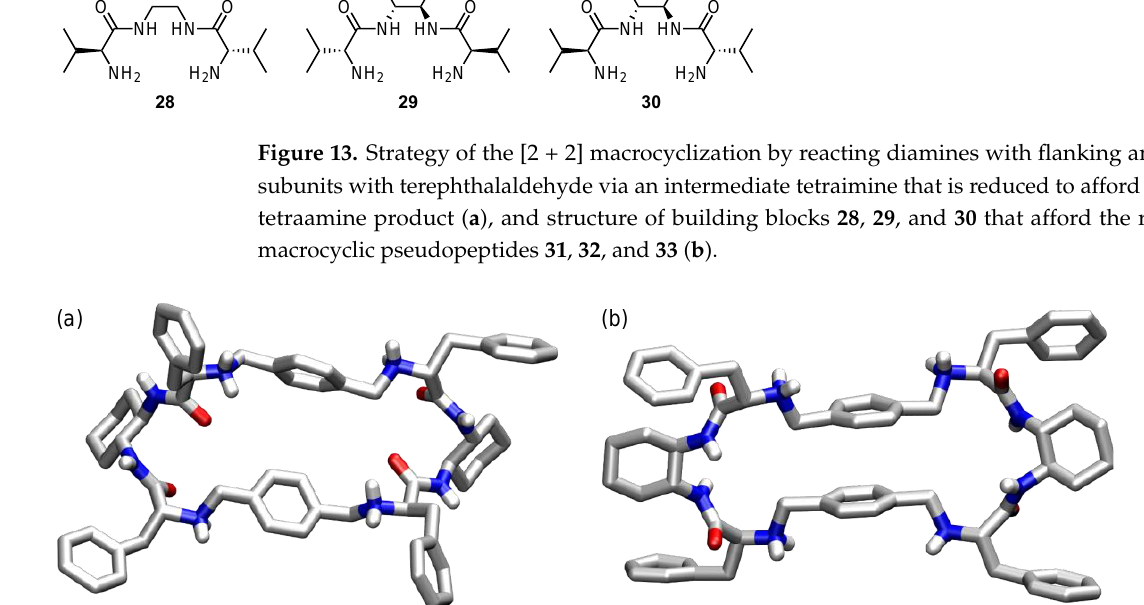
Figure 13. Strategy of the [2 + 2] macrocyclization by reacting diamines with flanking amino acid subunits with terephthalaldehyde via an intermediate tetraimine that is reduced to afford the stable tetraamine product ( a ), and structure of building blocks 28 , 29 , and 30 that afford the respective macrocyclic pseudopeptides 31 , 32 , and 33 ( b ).